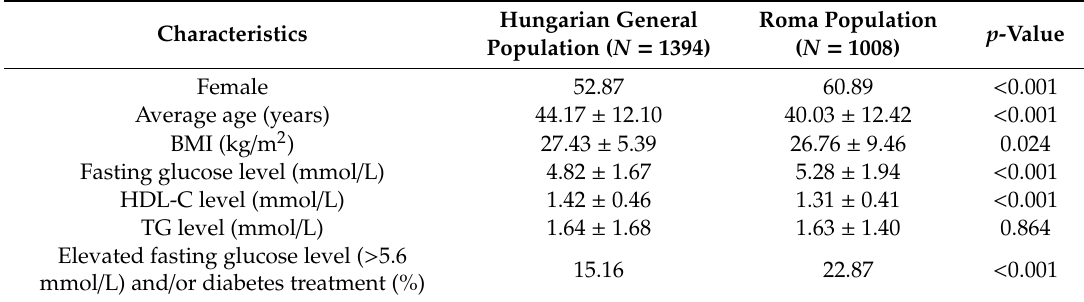
Table 2. Characteristics of study populations.